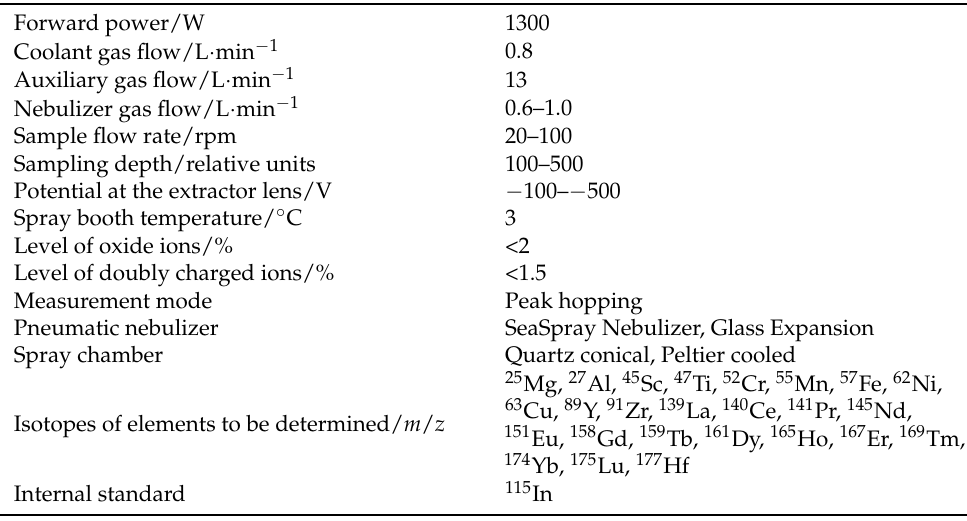
Table 3. Instrumental operating conditions of the